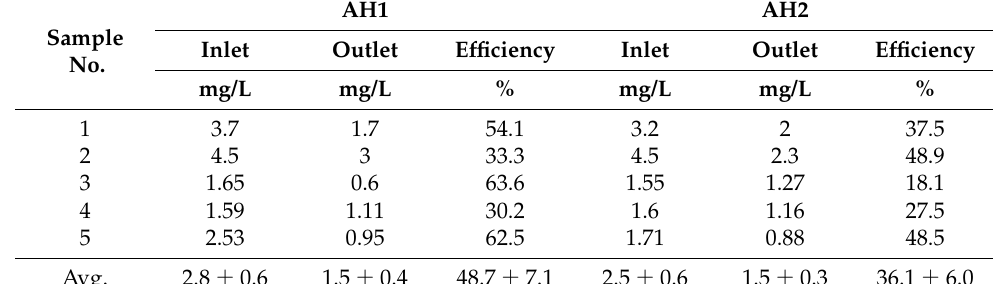
Table 7. Inlet and outlet N NH4 and removal efficiencies at stage II.